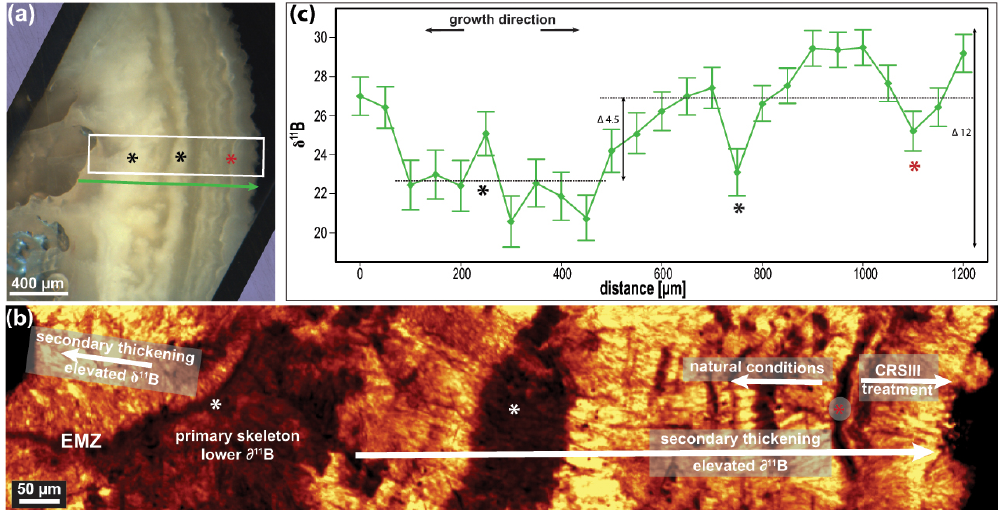
Figure 6. Old branch of Lophelia pertusa cut in transversal plane and prepared for Raman mapping and SIMS analysis. (a) Microscopic image of transversal cut through an old branch displaying the location of the Raman map and SIMS transect. (b) Raman map of the intensity distribution of the main aragonite peak (symmetric stretch, 1085cm − 1 ) reveals the early mineralization zone (EMZ), the primary skeleton and the area of secondary thickening. Asterisks mark EMZ in the primary skeleton and skeletal areas within the secondary thickening zone of potentially reduced Boron isotopic value (cf. opaque growth bands in Blamart et al., 2007 or 1 ◦ , 2 ◦ nucleation zone in Cohen et al., 2006). Red asterisk marks the location of the staining line and hence, the border between growth under natural/control condition and laboratory treatment. (c) δ 11 B measured in growth direction from inside to the outer coral skeletal rim (transect